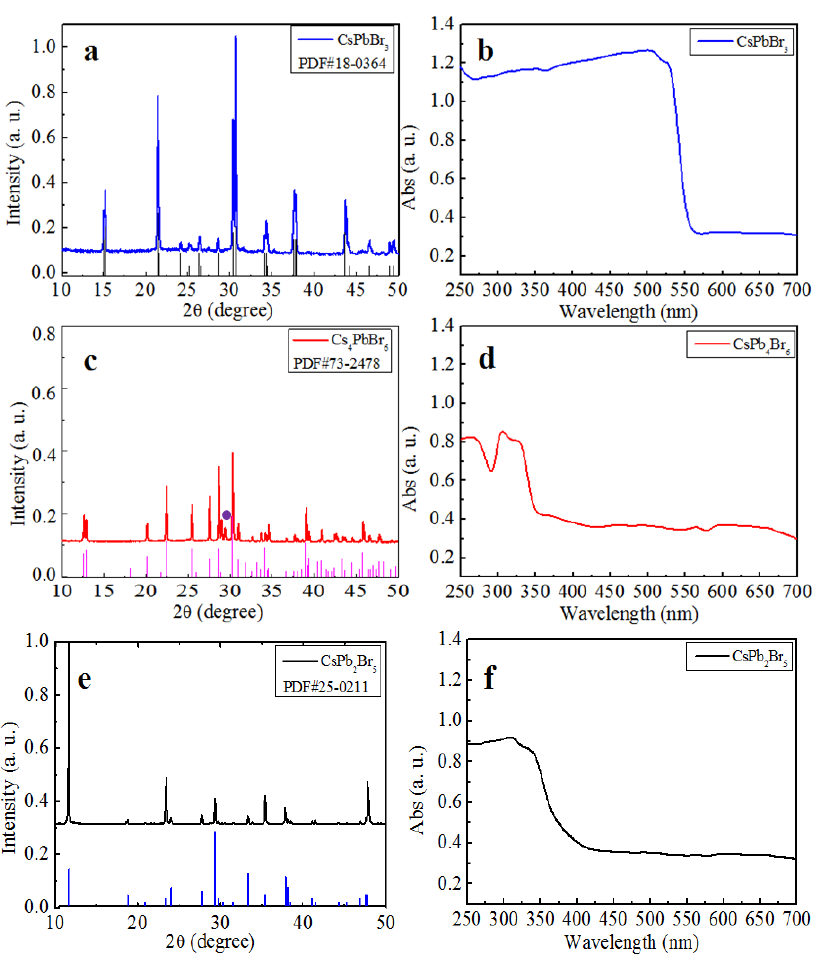
Figure 1. The XRD pattern of ( a ) CsPbBr 3 , ( c ) Cs 4 PbBr 6 and ( e ) CsPb 2 Br 5 . The absorption spectra of ( b ) CsPbBr 3 , ( d ) Cs 4 PbBr 6 , and ( f ) CsPb 2 Br 5 .